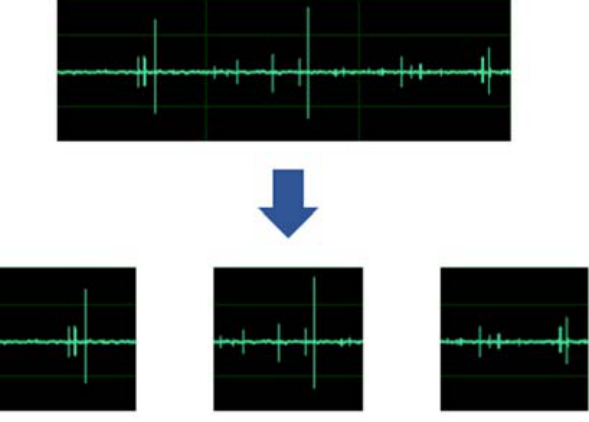
Figure 3. Schematic diagram of cutting.